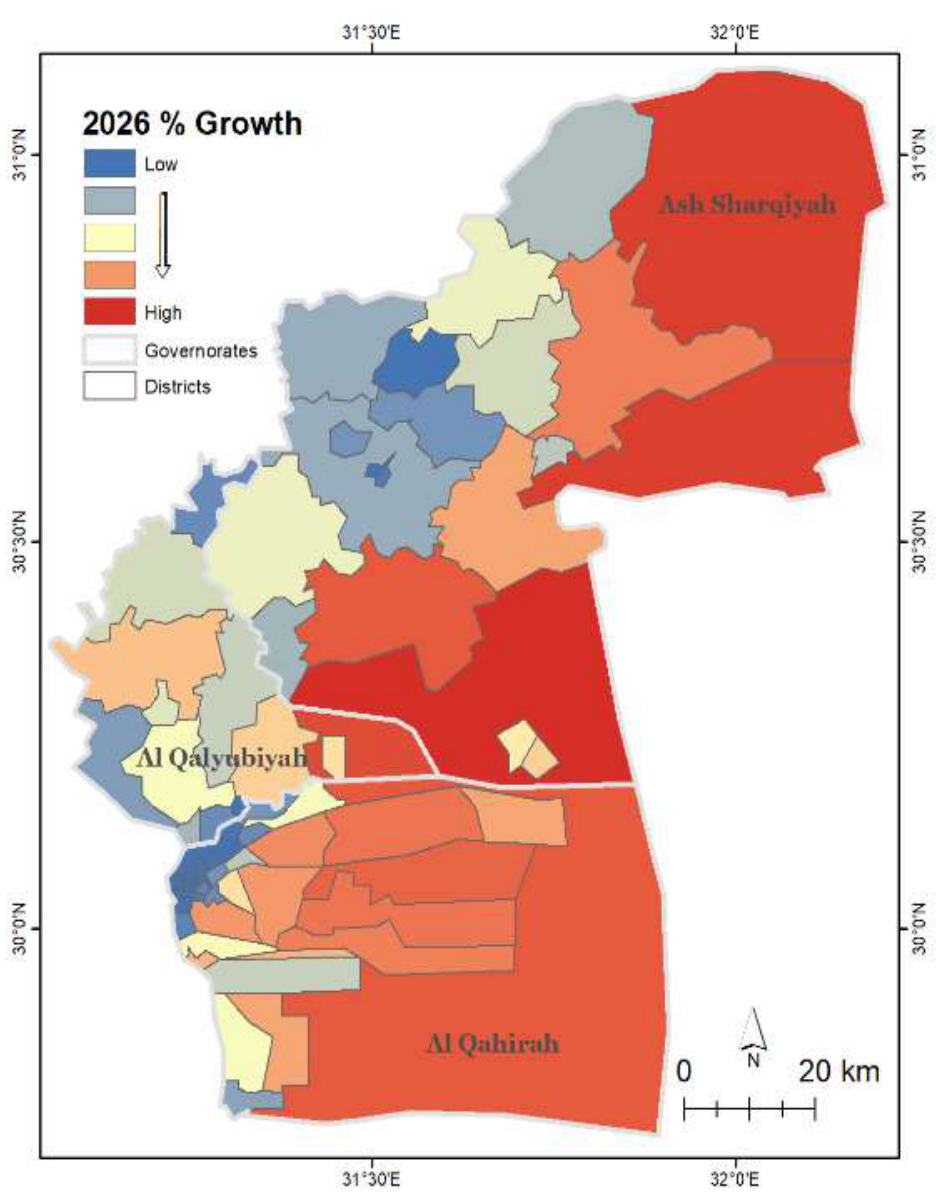
Figure 7. The simulated percent growth in urban areas for the year 2026. Areas in red are simulated to experience the highest growth rates, whereas areas in blue are expected to experience the lowest. Most of the blue districts are areas that were nearly 100% urban, thus there was minimal possibility for expansion.